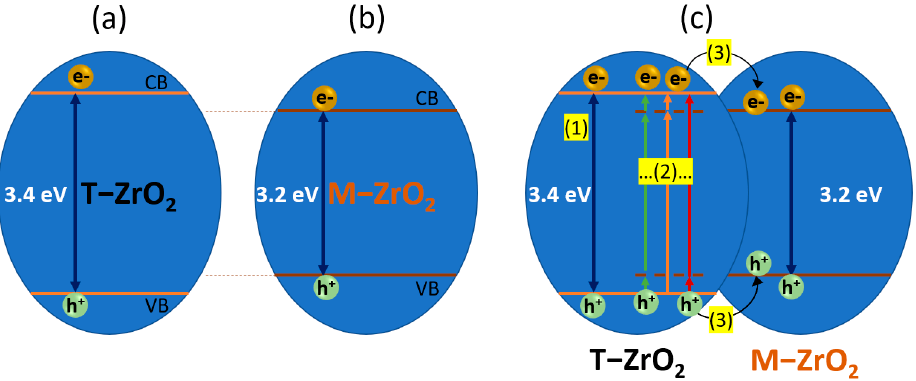
Figure 12. ( a – c ) The possible photocatalytic mechanism of ZrO2 nanotubes. (1), (2) and (3) are the possible photo-generated electron pathways (for more details, see text).